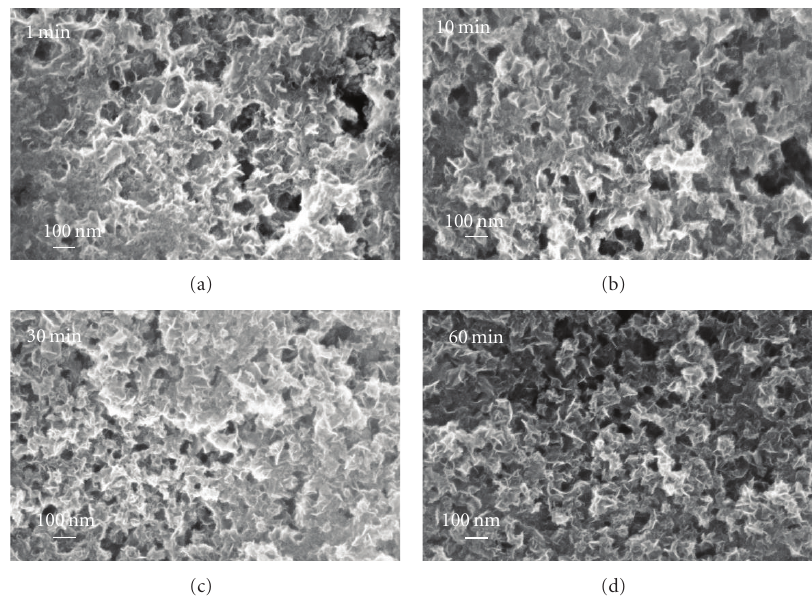
Figure 1: FESEM micrographs of self-assembled MnO 2 thin films deposited on Ni/PET substrates at various submersion durations (a) 1min, (b) 10min, (c) 30min, and (d) 60